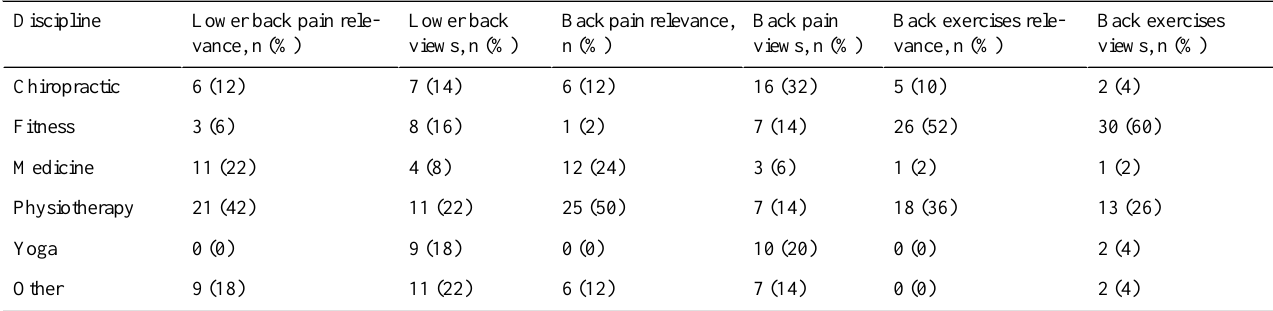
Table 1. Percentage of videos from each discipline by search term, views, and relevance in raw data set.